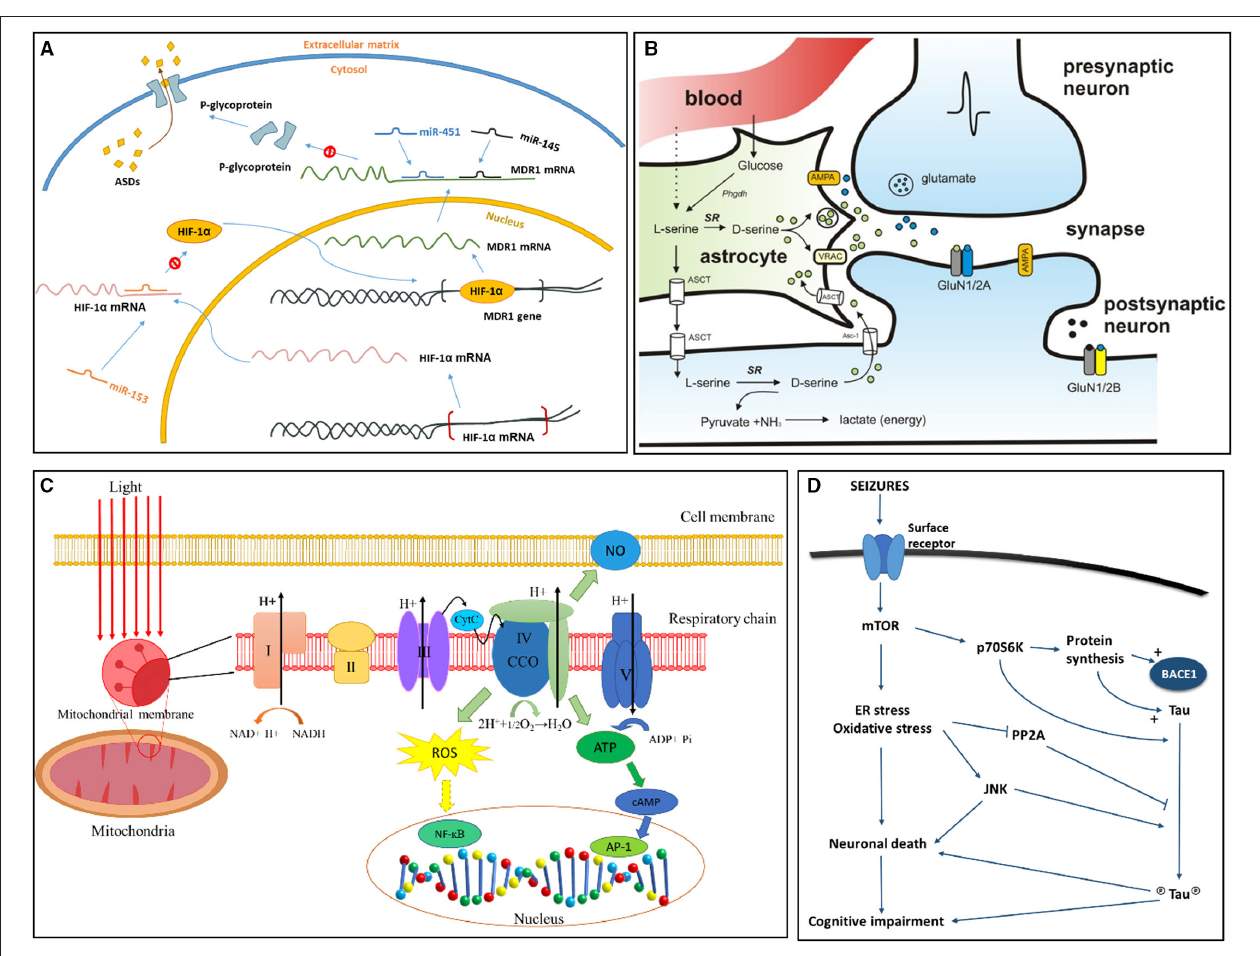
FIGURE 2 | Signaling pathways more recently proposed to TLE epileptogenesis and associated conditions. (A) Role of miRNA in pharmacoresistant epilepsy (39). Binding of miR-153 blocks the translation of hypoxia-inducible factor 1 α (HIF-1 α ) mRNA. Without limitation of miR-153, HIF-1 α mRNA is translated, and HIF-1 α protein transports to the nucleus, binding to the multidrug resistance gene 1 (MDR1) gene as a transcriptional regulator. When MDR1 mRNA enters cytoplasm, it translates into P-glycoprotein, which combines to the cell membrane pumping antiseizure drugs (ASDs) out of the cell. Existence of miR-145 and miR-451 can inhibit translation of MDR1 mRNA by binding to its 3’ untranslated region, thus decreasing expression of P-glycoprotein. (B) D-serine synthesis and release pathway ( 40). Activation of presynaptic neurons induce the release of glutamate, which bind to AMPA receptors on neighboring astrocytes to release D-serine. D-serine is transformed from L-serine by serine racemase (SR). N-methyl-D-aspartate receptor (NMDAR)-containing GluN2A subunits are major binding sites of D-serine. Glycine competes with D-serine for the binding of GluN2B. (C) Reactive Oxygen Species (ROS) signaling in mitochondria ( 41). Respiratory chain exists on the inner membrane of mitochondria and is composed of five subunits (I, II, III, IV, V). Unit IV of respiratory chain is also known as cytochrome c oxidase (CCO), it reduces oxygen into water through electron transport. Electron transport further produces ATP and ROS. The oxidative stress associated with ROS will change the level of NF-kB, AP1, and cAMP, and these factors are actively involved in gene translation and expression and may result in cell death. AP1, activator protein 1; ATP, adenosine triphosphate; CCO, cytochrome c oxidase; CytC, cytochrome C; H + , hydrogen ions; cAMP, cyclic adenosine monophosphate; NF-kB, nuclear factor kappa B; NO, nitric oxide. (D) Hypotheses for tau pathology on cognitive impairment and epileptogenesis in TLE (42). Seizures induce the activation of surface receptors, involving excitatory neurotransmitter receptors, which further activates the mTOR pathway leading to an increase in endoplasmic reticulum (ER) stress and oxidative stress. These chronic stresses will result in neuronal death and subsequent cognitive impairment. p70S6K, a ribosomal protein kinase downstream of activated mTOR, stimulates the synthesis of tau and BACE1 proteins directly phosphorylates tau (circled P). Cellular stress also induce activation of pro-apoptotic JNK, and inhibiting PP2A activity. PP2A is a major tau phosphatase and can decrease tau phosphorylation upon activation. Figures were modified with